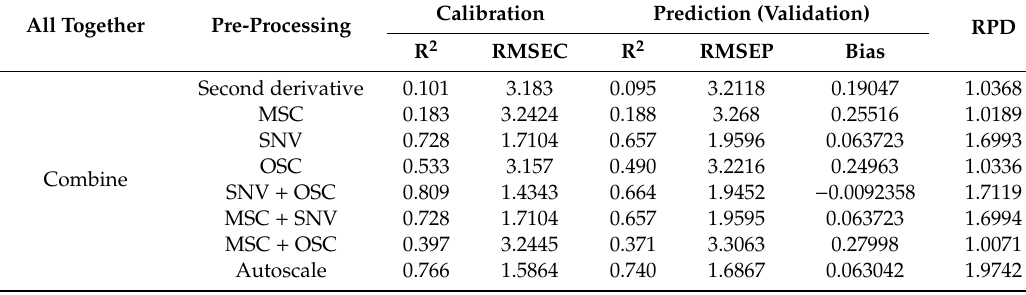
Table 11. SVM-R results of combine data with second derivative and their preprocessing at a spectral sampling range of 729–975